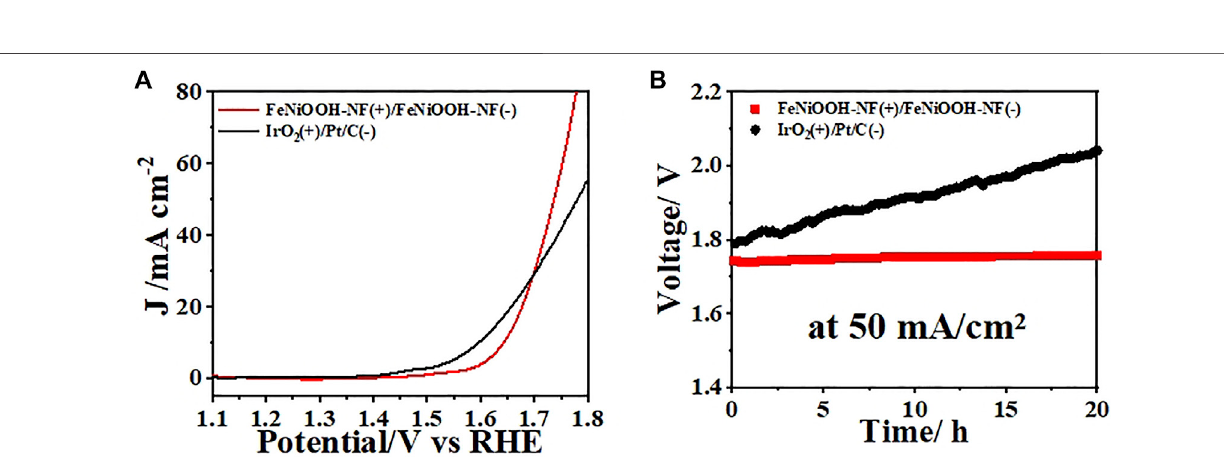
Frontiers in Chemistry |